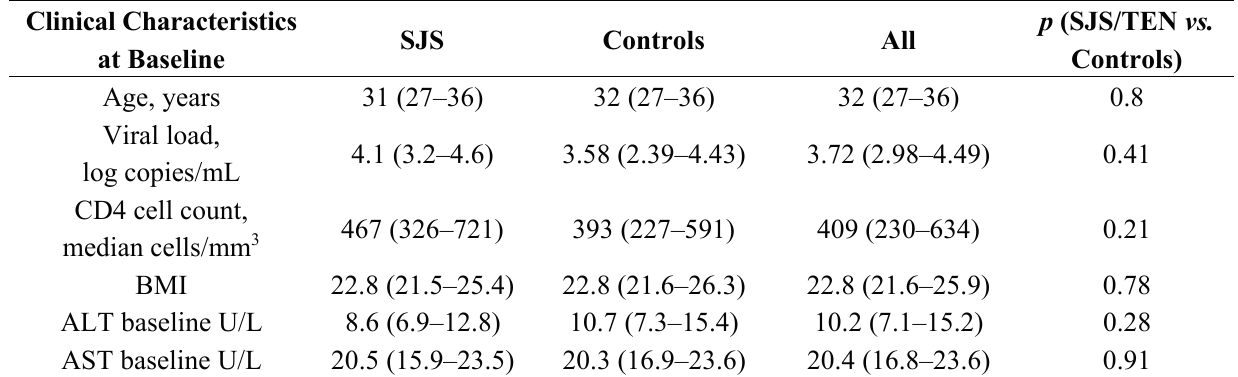
Table 1. Clinical baseline characteristics of